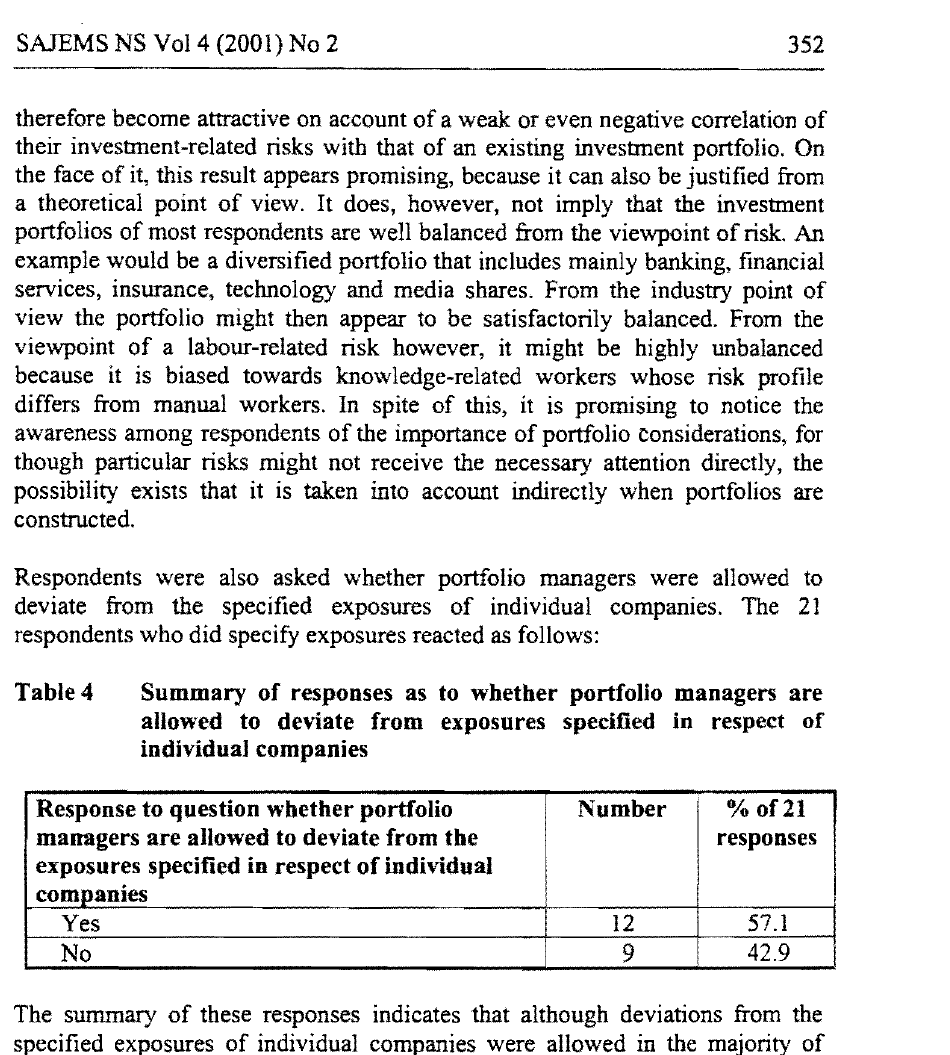
Summary of responses as to whether portfolio managers